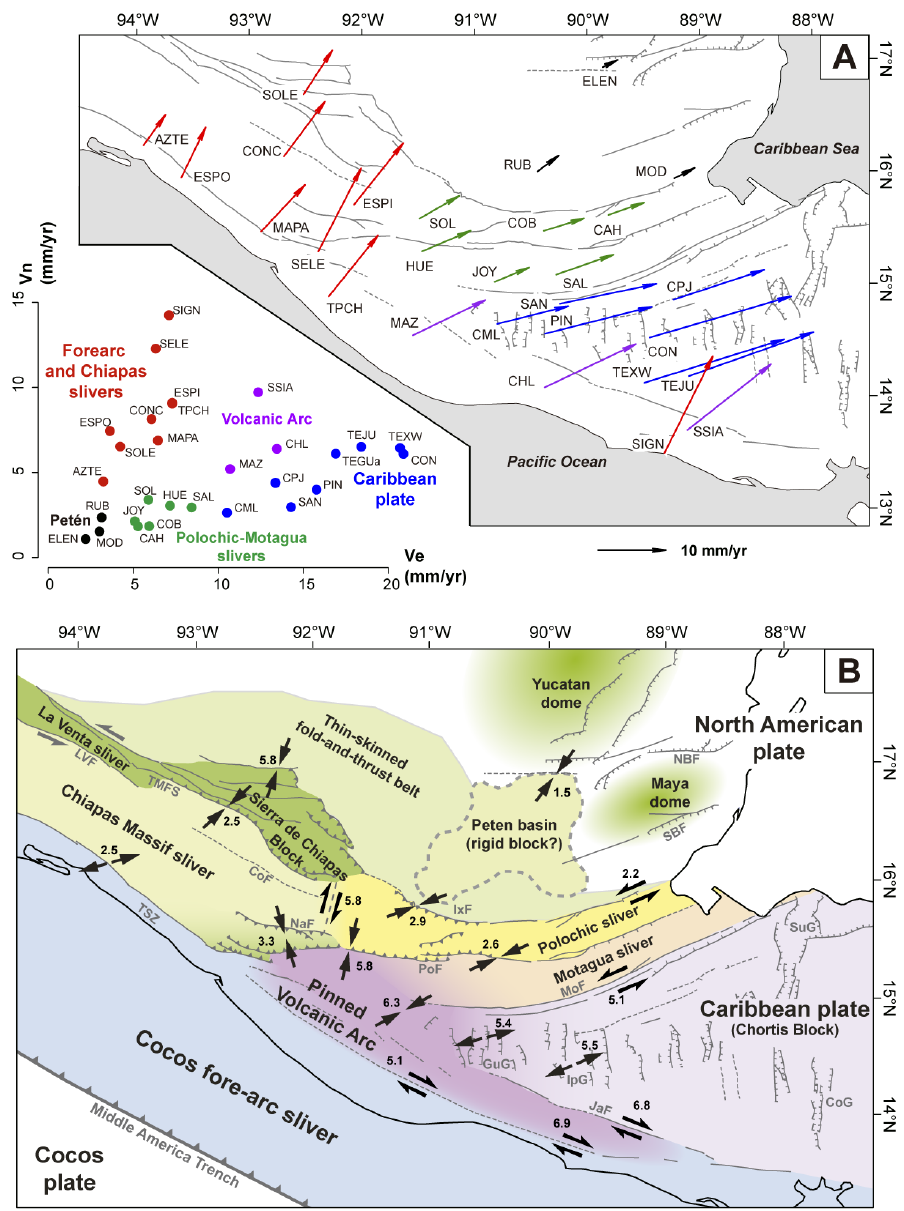
Figure 18. Proposed limits of tectonic slivers forming the plate boundary. (a) GPS velocities with respect to the fixed North American Plate (Franco et al., 2012). Colors emphasize vectors with similar azimuths and velocities. The diagram of northern and eastern components (bottom left corner) allows for motions between paired GPS stations to be deduced. (b) Main tectonic blocks defined using known major faults (Fig. 2), our geomorphic maps (Figs. 7 and 8) and published GPS data (Fig. 18a) and seismicity (Fig. 3a). Black arrows show the motion along block boundaries deduced from paired GPS stations (values are in mmyr − 1 ). See Fig. 2 for faults